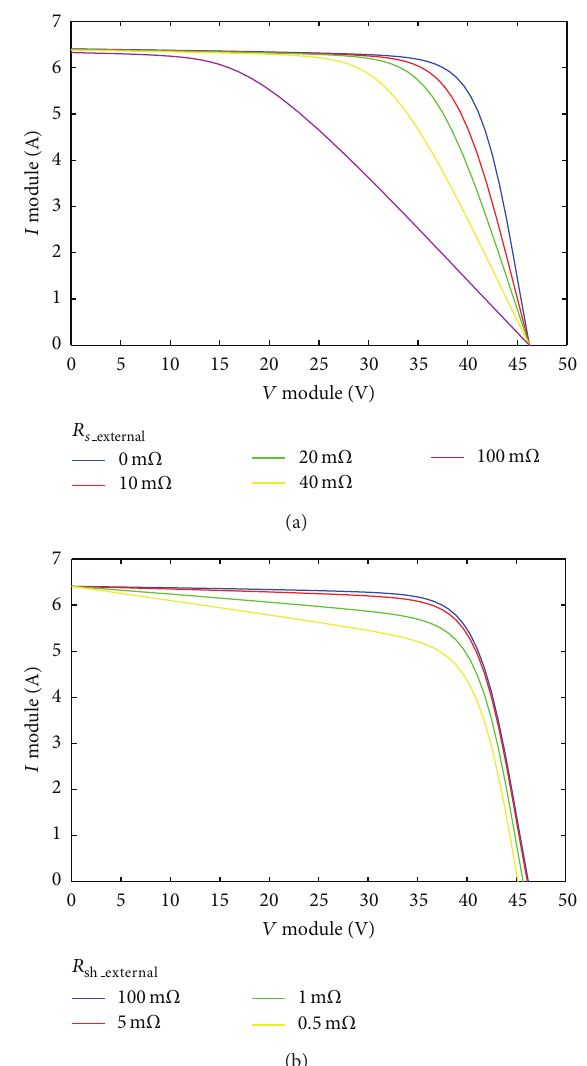
Figure 10: Effects of parasitic resistance on the simulated 𝐼 - 𝑉 characteristics of 230 cm 2 CIGS solar cell. (a) Increasing external series resistance. (b) Increasing external shunt